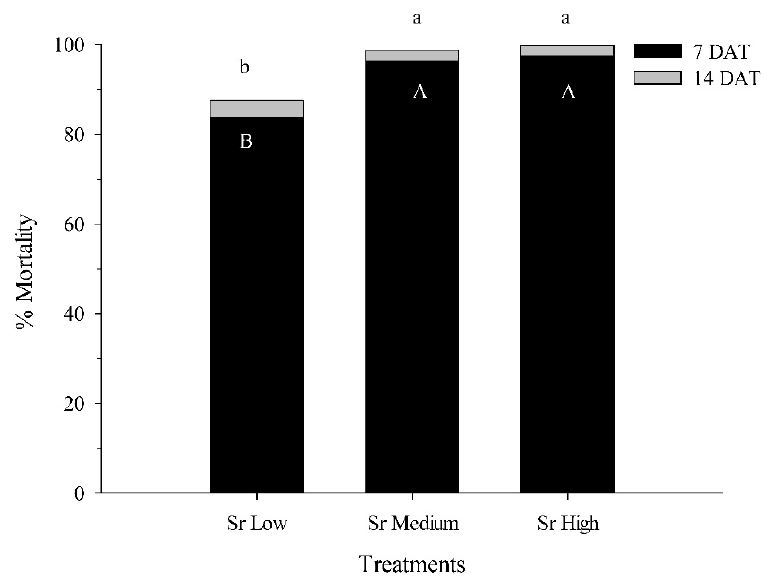
Figure 4. Percentage mortality ( ± SEM) of Conotrachelus nenuphar pupae at 7 and 14 days after treatment (DAT) with three rates (100, 200, 400 infective juveniles) of the entomopathogenic nematodes Steinernema riobrave (Sr) in 30-mL cups with 20 g moist blueberry soil and one pupa. Bars with same